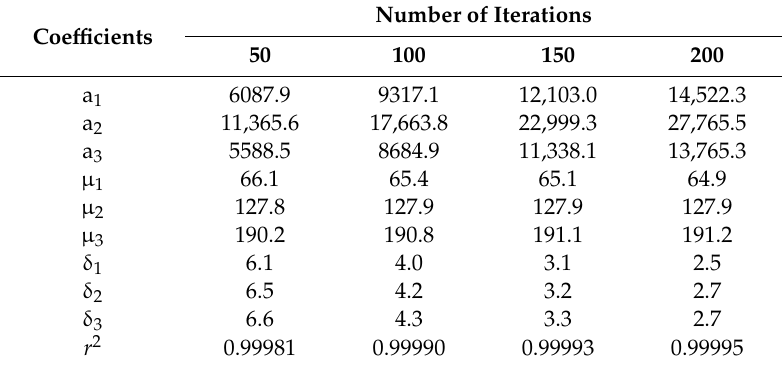
Table 1. The fitted values in the grey value distribution models for the images reconstructed from the phase-only holograms calculated by GS algorithm with different numbers of iterations. Number of Coe ffi cients